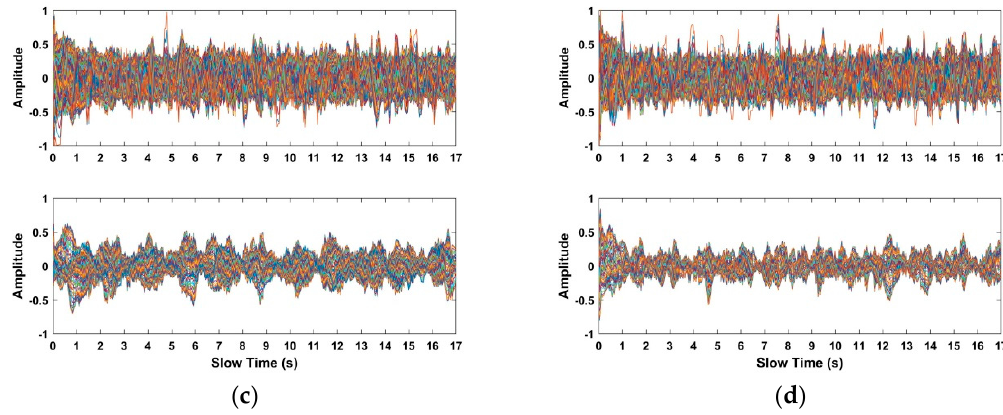
Figure 14. The selected signals in the interested region based on the acquired data from the used actuator at distances ( a ) 4 m; ( b ) 7 m; ( c ) 10 m; and ( d ) 12 m indoors.